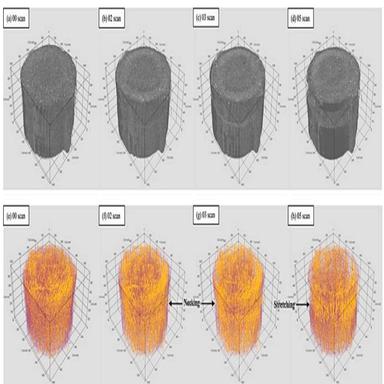
3D rendering of reconstructed tomography (top) and segmented fiber phase (bottom) for SHCC sample under the in-situ ensile microtomographic test at different scans.